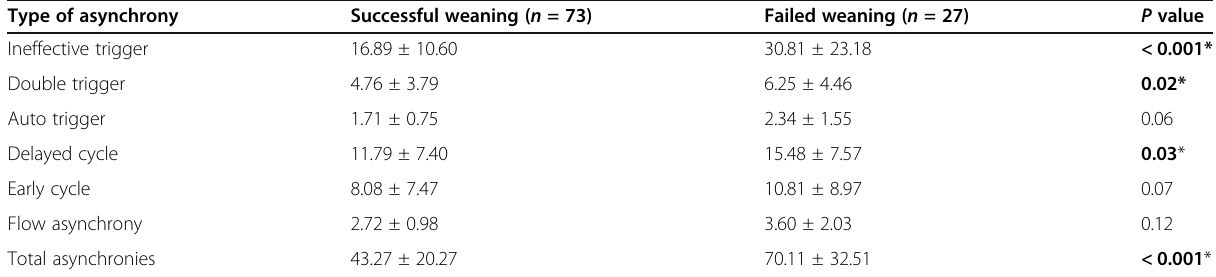
Table 2 Patients ’ asynchronies in studied patients based on the outcome of weaning Type of